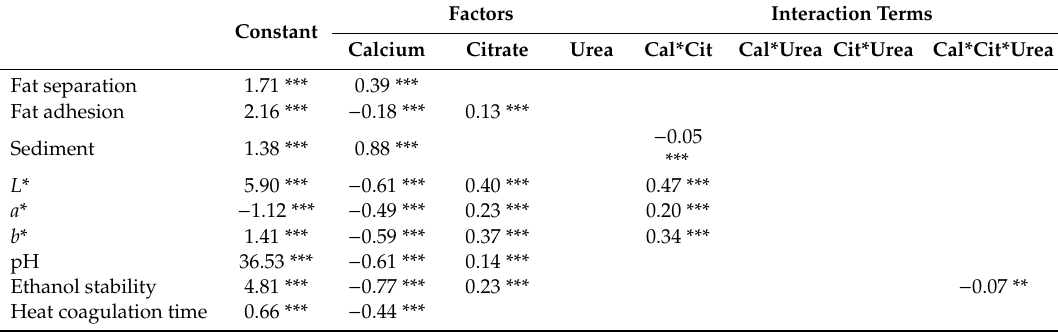
Table 2. Significant regression coe ffi cients relating to normalized variables for ultra-high temperature treated milk stored for 0–52 weeks at 4, 20, 30, and 37 ◦ C. The size of the coe ffi cient represents the change in response when a factor varies from normal to elevated level. *** p ≤ 0.001, and ** p ≤ 0.01. Constant